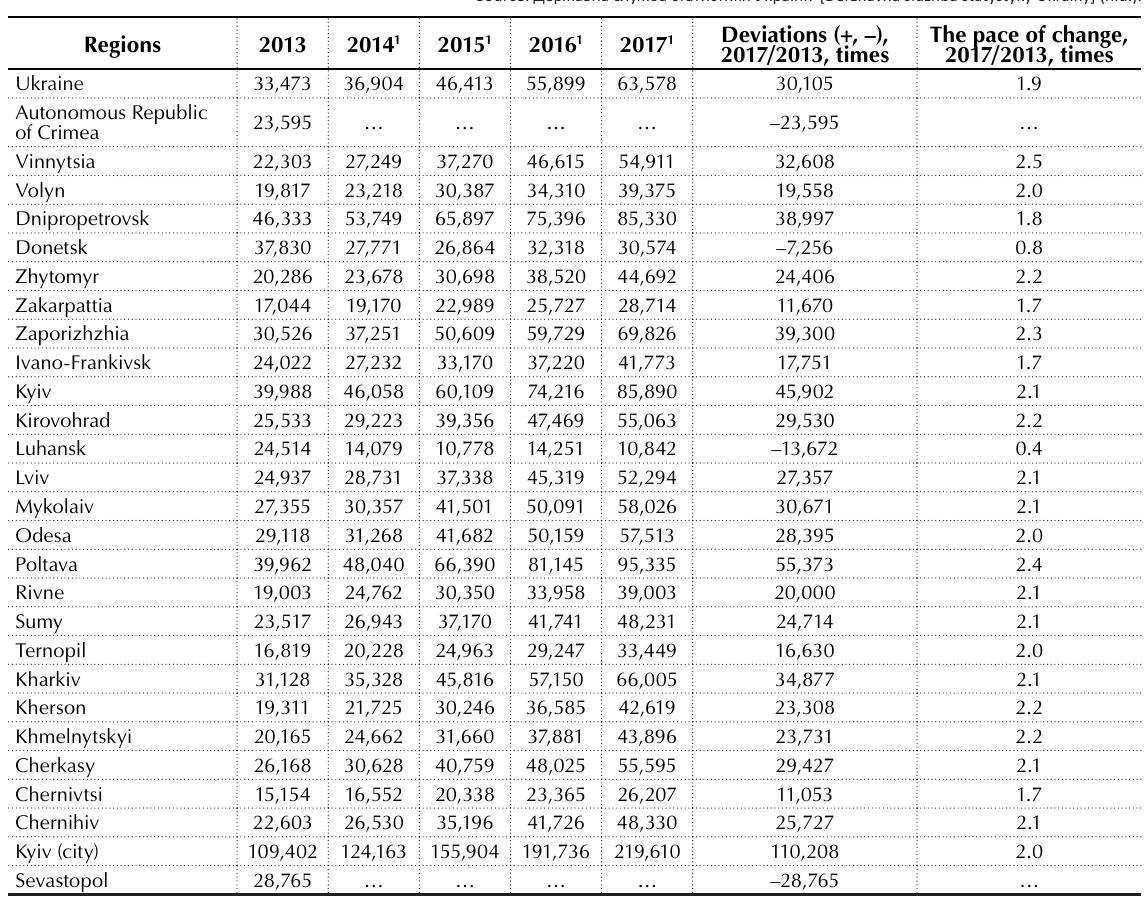
Table 2. Dynamics of the gross regional product in the calculation per capita for